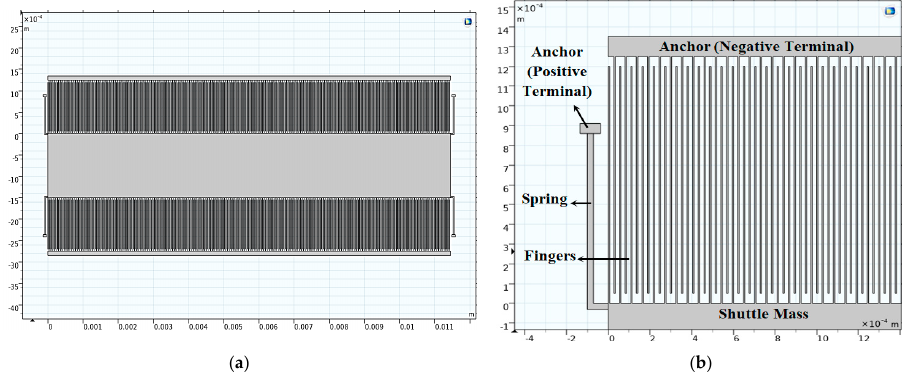
Figure 12. ( a ) The 2D optimized converter structure and ( b ) a focus of the structure showing a clear view.